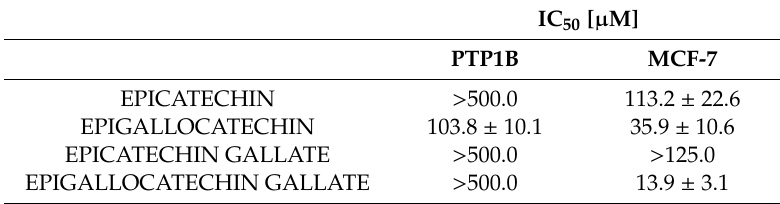
Table 1. Inhibitory activity of compounds as calculated IC 50 values against PTP1B phosphatase enzymatic activity in comparison to the calculated IC 50 values against MCF-7 viability.